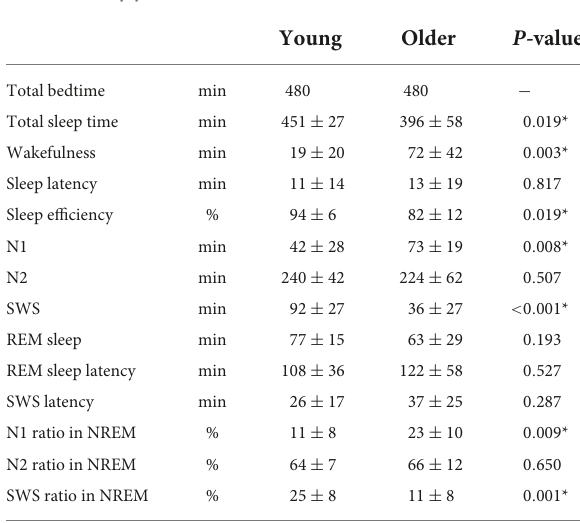
TABLE 2 Sleep parameters.